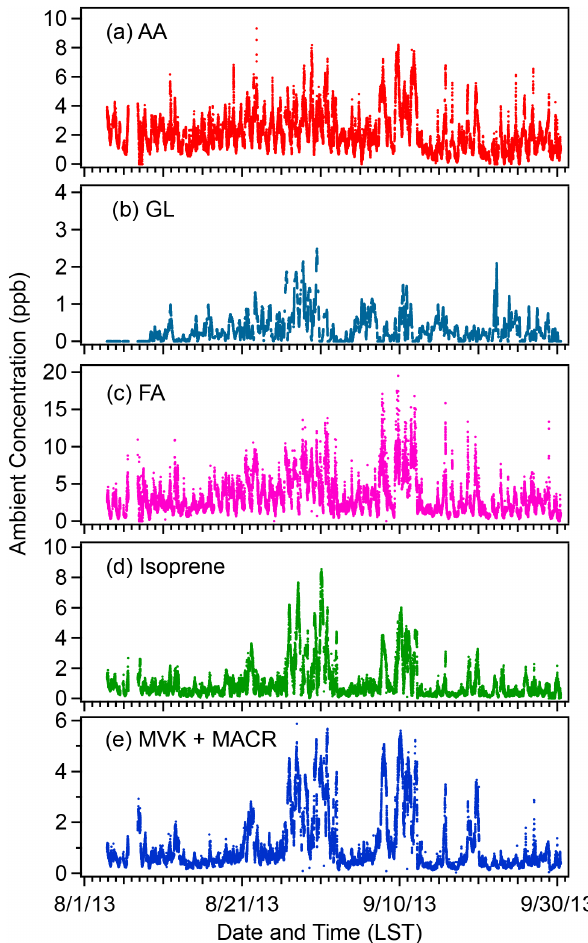
Figure 12. Time series of ambient (a) AA, (b) glycolaldehyde (GL), (c) FA, (d) isoprene, and (e) MVK + MACR mixing ratios measured by PTR-MS in East St. Louis, USA, during the SLAQRS measure- ment campaign. See text for